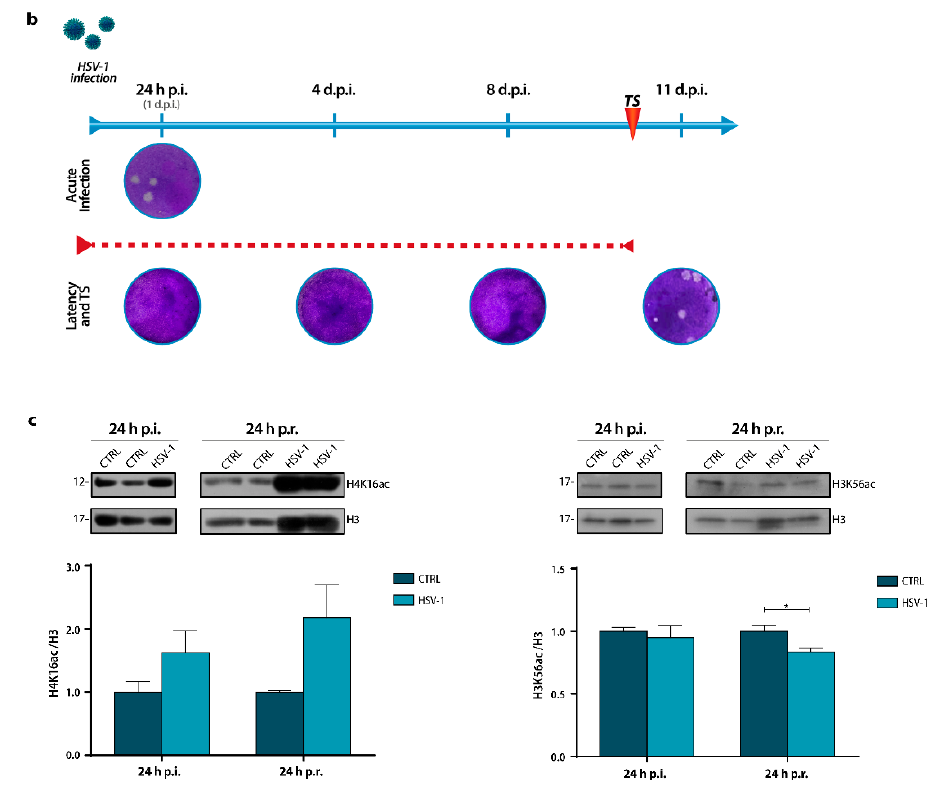
Figure 1. In vitro experimental model and histones acetylation levels during a recurrent HSV-1 infection in neurons . ( a ) Timeline of experimental procedures showing the days in culture of the neurons, the ACV treatment (red dashed line), the time of primary infection (DIV 7) and reactivation (DIV 17), and the time points chosen for the analyses: 24 h p.i. (DIV 8) and 24 h p.r. (DIV18). Abbreviations are shown in the yellow box. ( b ) Representative images of standard plaque assay (SPA) after primary infection (24 h p.i.) with or without ACV (Acute Infection and Latency and TS rows, respectively), during ACV-induced latency (4 and 8 d.p.i.) or after TS-induced reactivation (11 d.p.i.). ( c ) Representative immunoblots showing H4K16 and H3K56 acetylation levels in lysates from Mock- and HSV-1-infected neuronal cultures harvested 24 h p.i. or 24 h p.r.. H3 staining was used as a loading control. Densitometric analyses were performed with Quantity One software and normalized to H3 expression. The values represent the normalized fold-changes in acetylation levels from HSV-1 samples with respect to matched CTRL. Data are mean ± SEM. * p < 0.05. Statistical significance was calculated by the Mann–Whitney